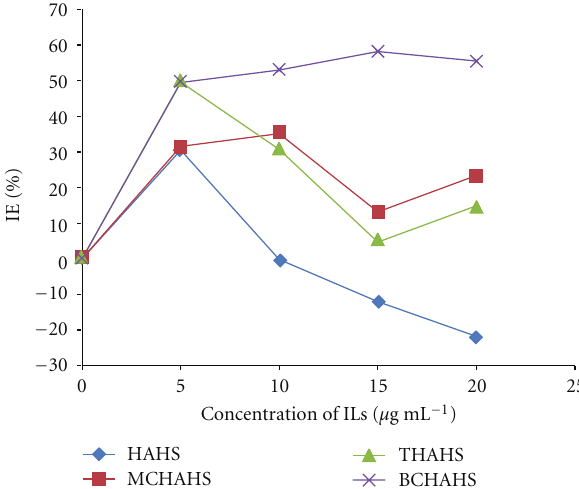
Figure 5: Inhibition e ffi ciency from polarization measurements in various concentrations of ILs. Conditions: scan rate, 5mVs − 1 ; H 2 SO 4 4.0mol · L − 1 ; immersion time, 5min.